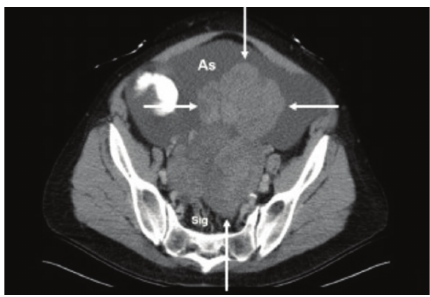
Figure 1: CT axial image of lower abdomen/pelvis demonstrating large predominantly solid mass (arrows) that appears to be arising from the retroperitoneum, surrounding sigmoid colon (Sig) and extending into peritoneal cavity. Mass is surrounded by a large amount of ascites (As).